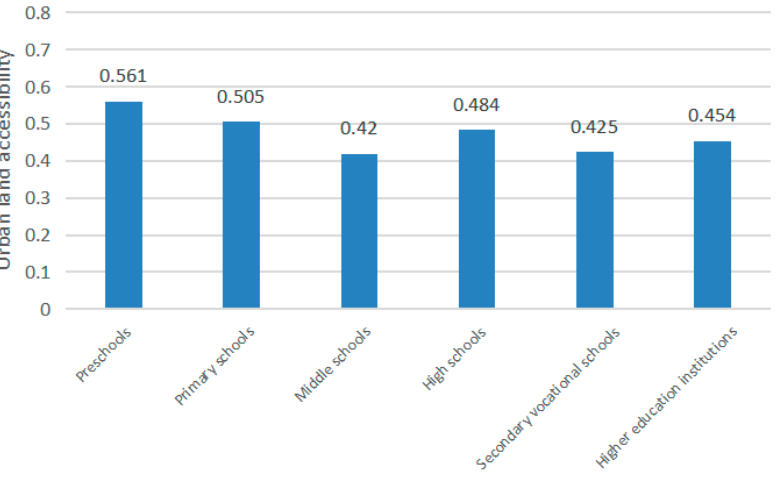
Figure 7. Graph of the average value of the comprehensive urban land accessibility of the locations of educational facilities at all levels.